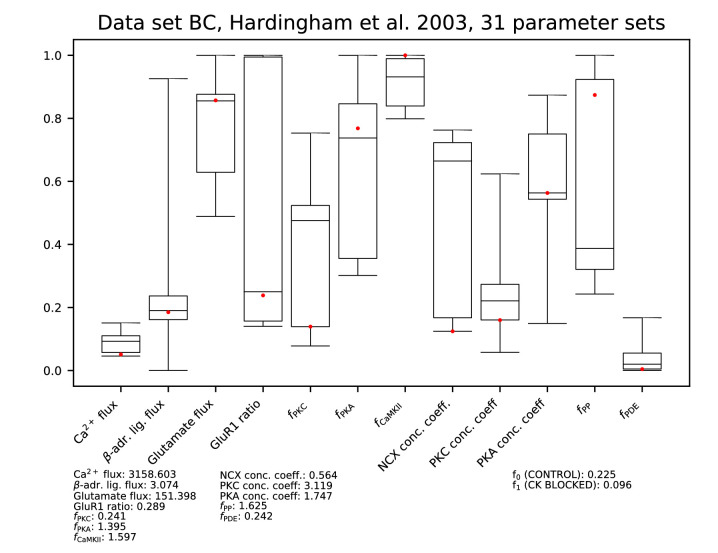
Parameters for data set BC.See Figure 9—figure supplement 1 for details.